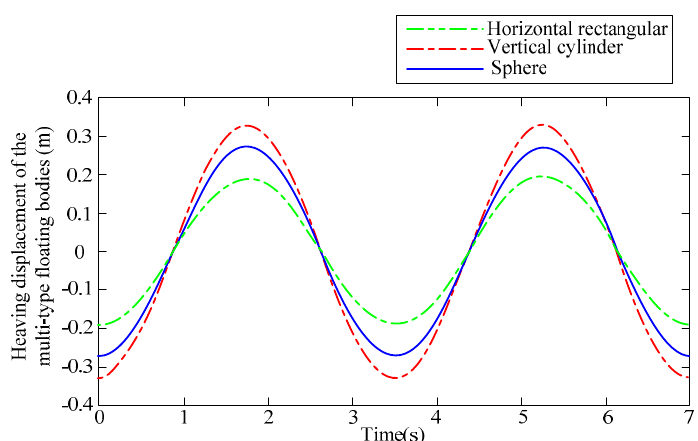
Figure 5. The heaving velocity of the multi-type floating bodies ( H = 0.3 m, T = 3.5 s).